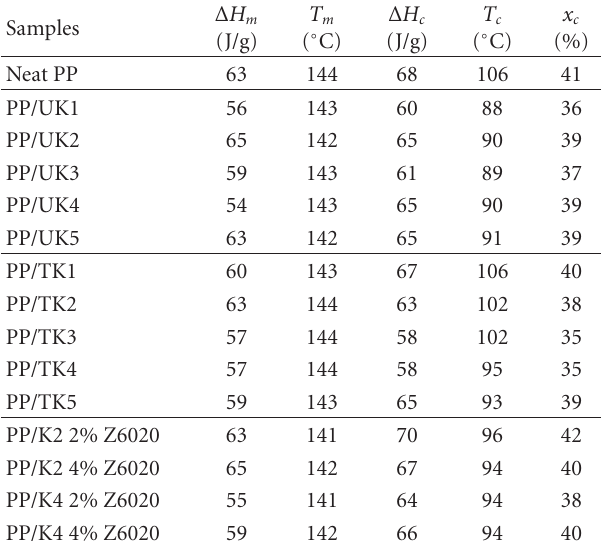
Table 3: PP/kaolin composites thermal characteristics determined from DSC scans.